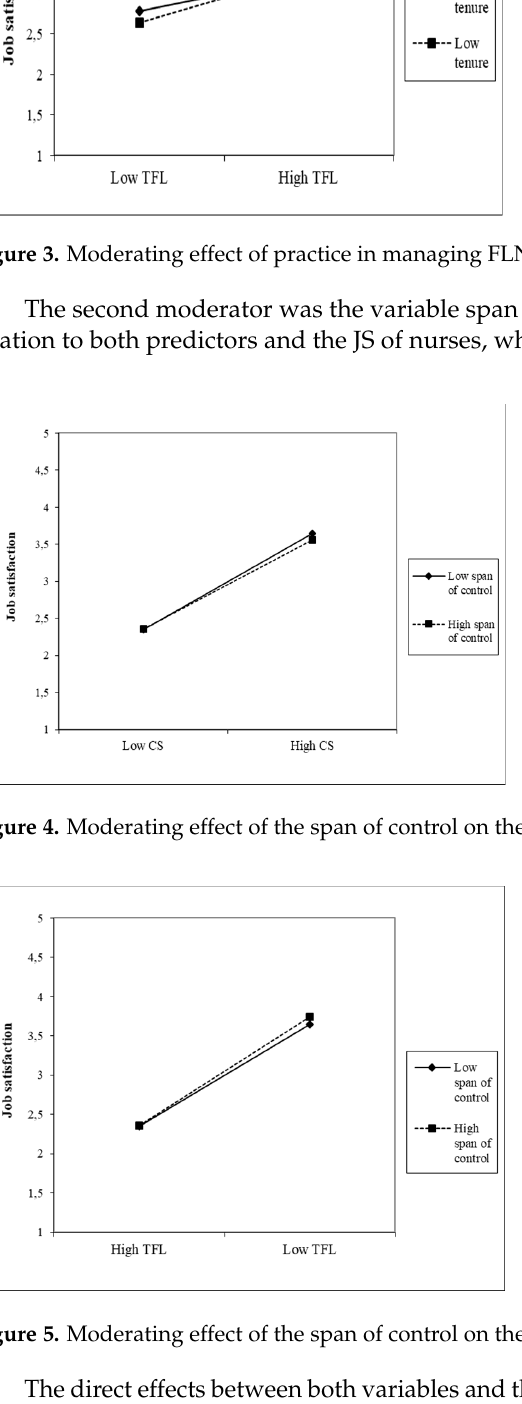
Figure 5. Moderating effect of the span of control on the TFL–JS relationship.